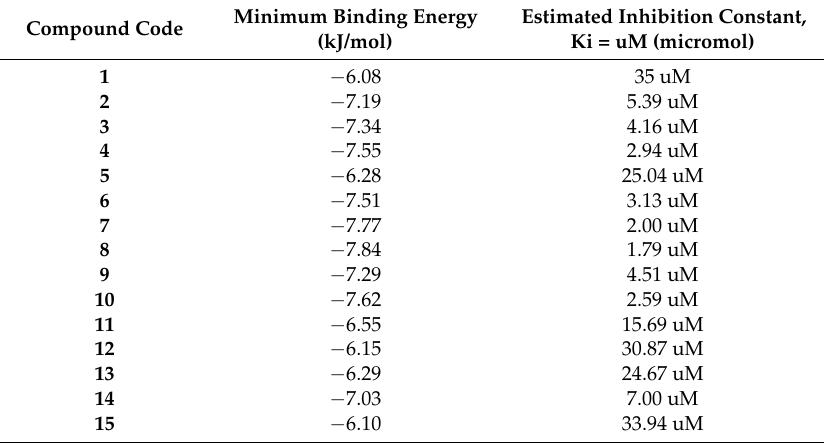
Figure 1. Docking into active site of glucosamine-6-phosphate (GlcN-6-P) synthase (PDB ID: 2VF5). ( A ) Docked poses of compounds 1 – 15 on the GlcN-6-P; ( B ) the interaction between the compound no. 14 and GlcN-6-P. Table 1. In silico molecular docking results of the synthesized compounds ( 1 – 15